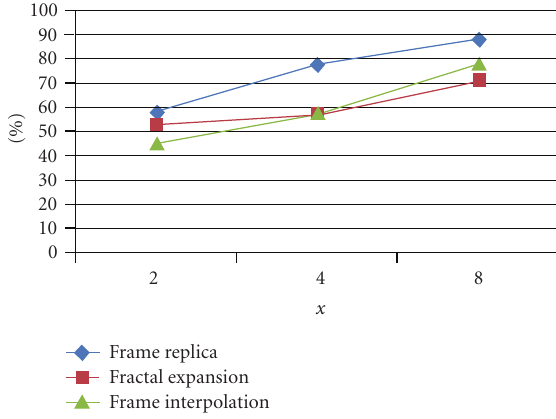
Figure 12: Measured jerkiness for CrowdRun